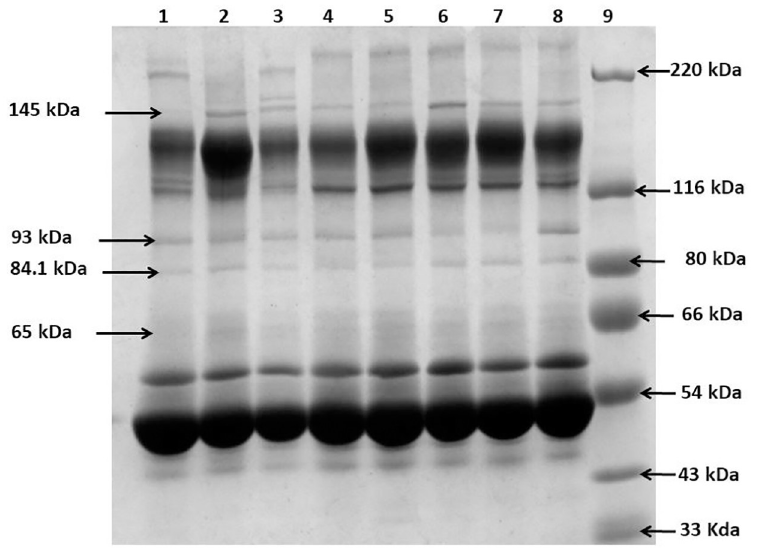
Fig 2. 1 DE SDS-PAGE analysis of the normal and LF infected human sera. Coomassie stained 7.5% SDS-PAGE of human serum sample, Lane 1. Normal-I, 2. Normal-II, 3. Asymptomatic-I, 4. Asymptomatic-II, 5. Acute-I, 6. Acute-II, 7. Chronic-I, 8. Chronic-II, 9. Mol.